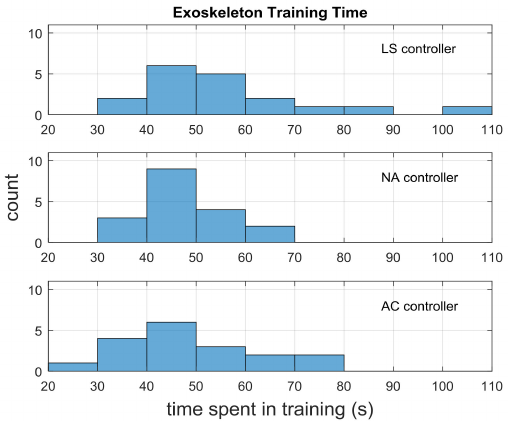
Figure 5. Distribution of the time spent completing the six-motion training task across all subjects. The mean and standard deviation were 51 s and 14 s respectively.